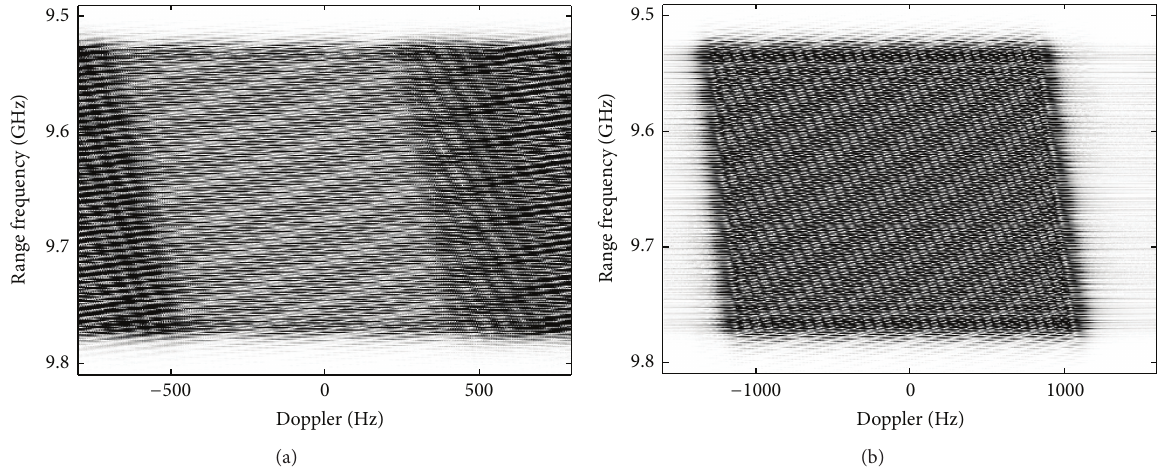
Figure 5: 2D spectrum (a) before and (b) after spatial filtering.